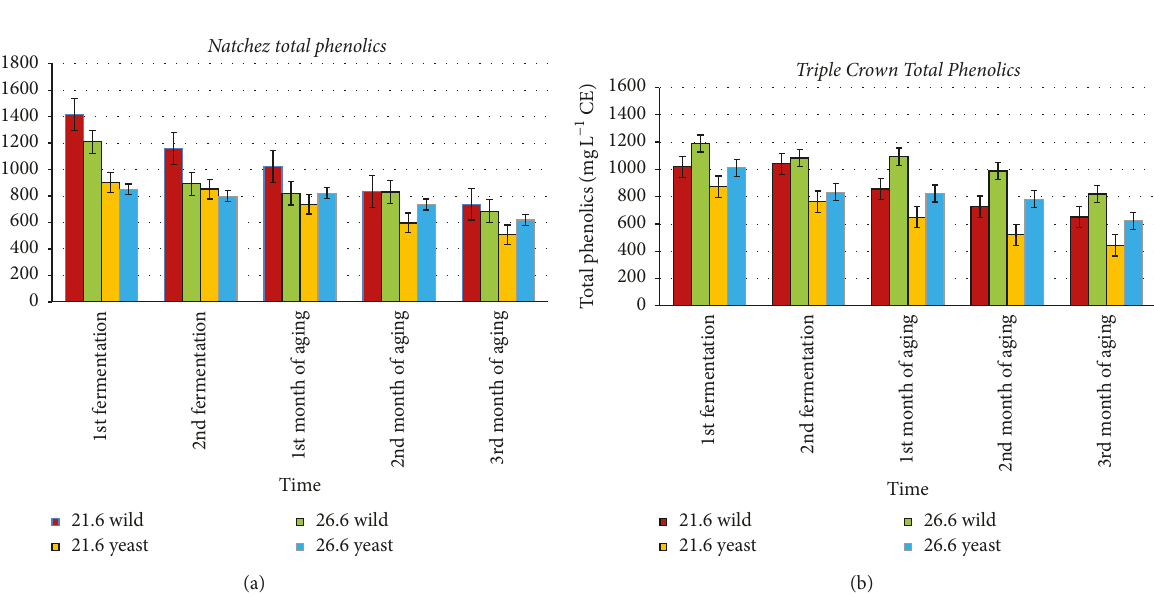
a Means with a and b letters indicate significant differences between fermentation temperatures within cultivar and inoculation treatment ( 𝑝 < 0.05 ). b Means with c and d letters indicate significant differences between cultivars within inoculation treatment and fermentation temperature ( 𝑝 < 0.05 ). c Means with e and f letters indicate significant differences between inoculation treatments within cultivar and fermentation temperature ( 𝑝 < 0.05 ).